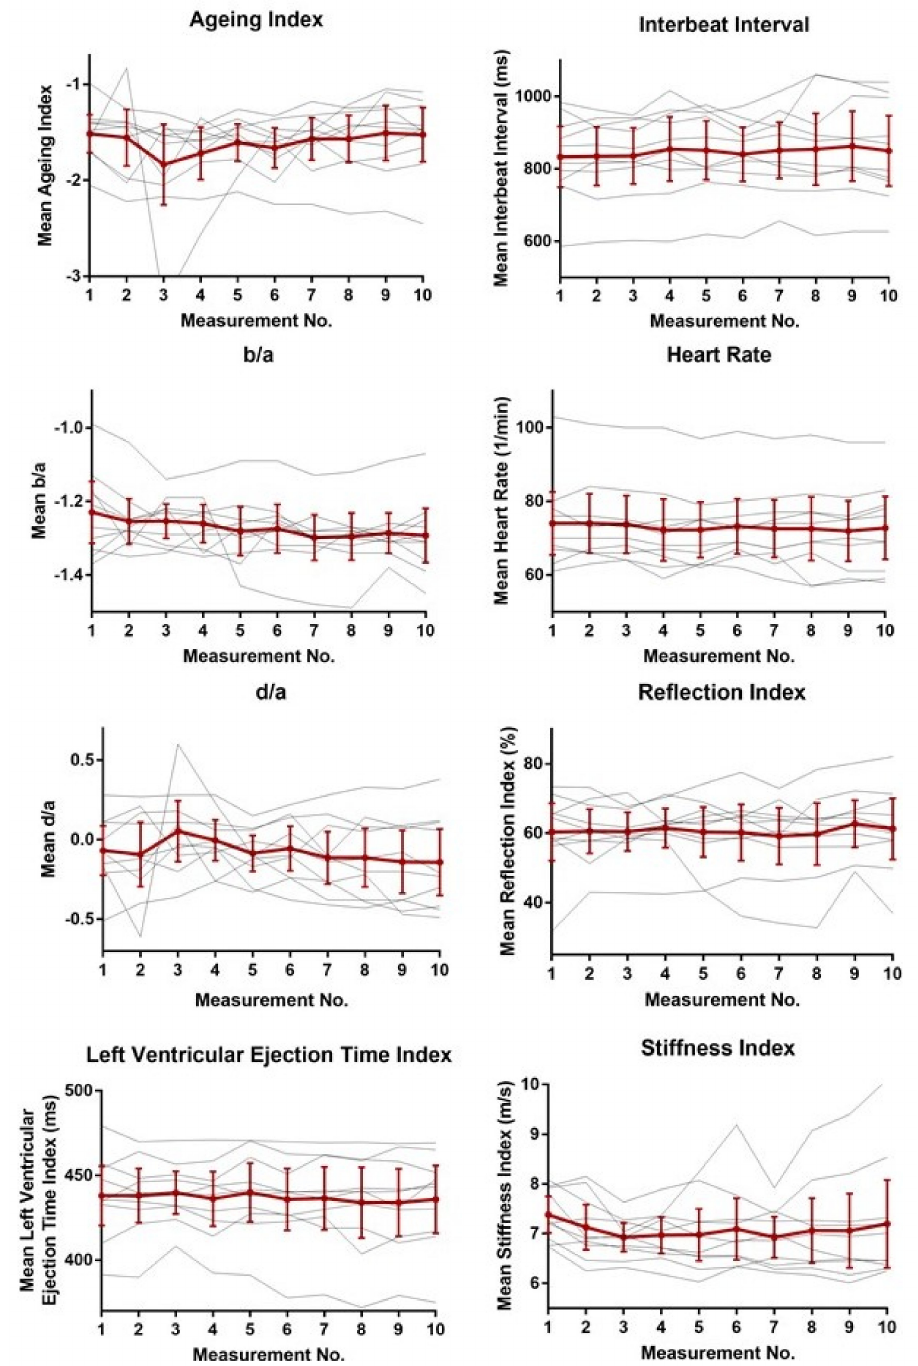
Figure 4. Graphs demonstrating the relationship between interpersonal variability and intrapersonal variations of the computed pulse contour parameters. Measurements were performed on 10 healthy volunteers 10 times repeatedly under standardized conditions. Means ( ± confidence intervals) are presented (red solid line) for each consecutive measurement along with individual measurement data (black lines). Individual lines are similar to each other and to the average line. The variability of the individual curves among measurements and the variability between the individual curves seem to fall in the same order of